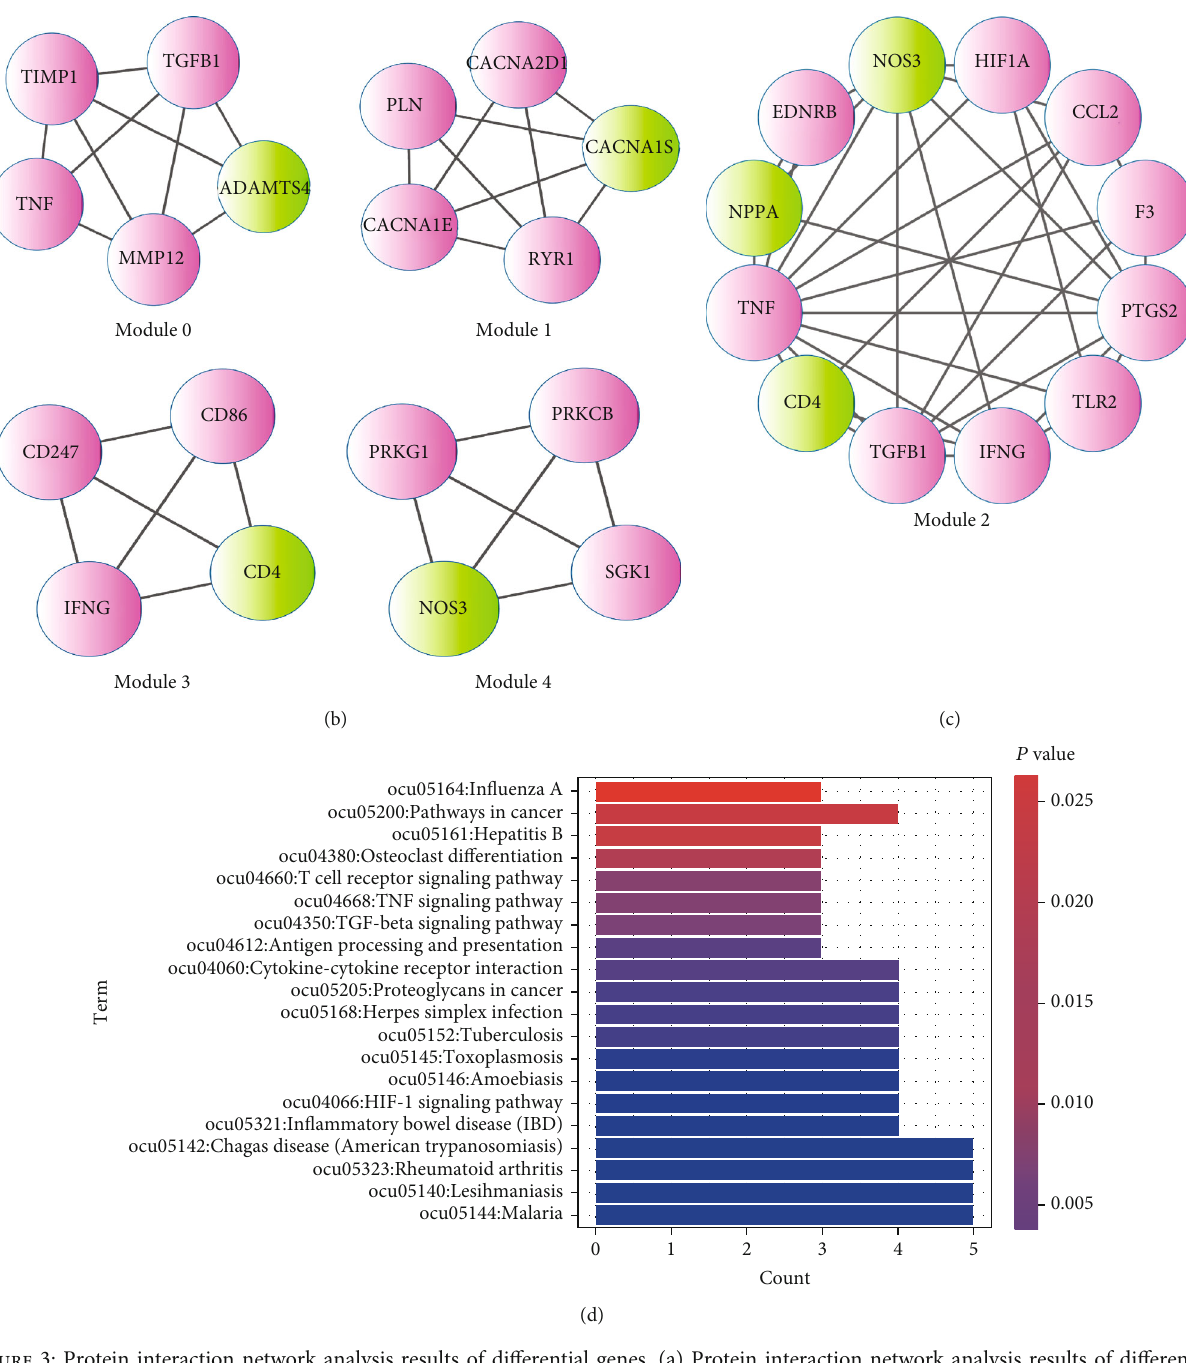
Figure 3: Protein interaction network analysis results of di ff erential genes. (a) Protein interaction network analysis results of di ff erential genes. (b, c) Five subnetwork modules found by CFinder software. (d) KEGG enrichment analysis results of module 2 network module node